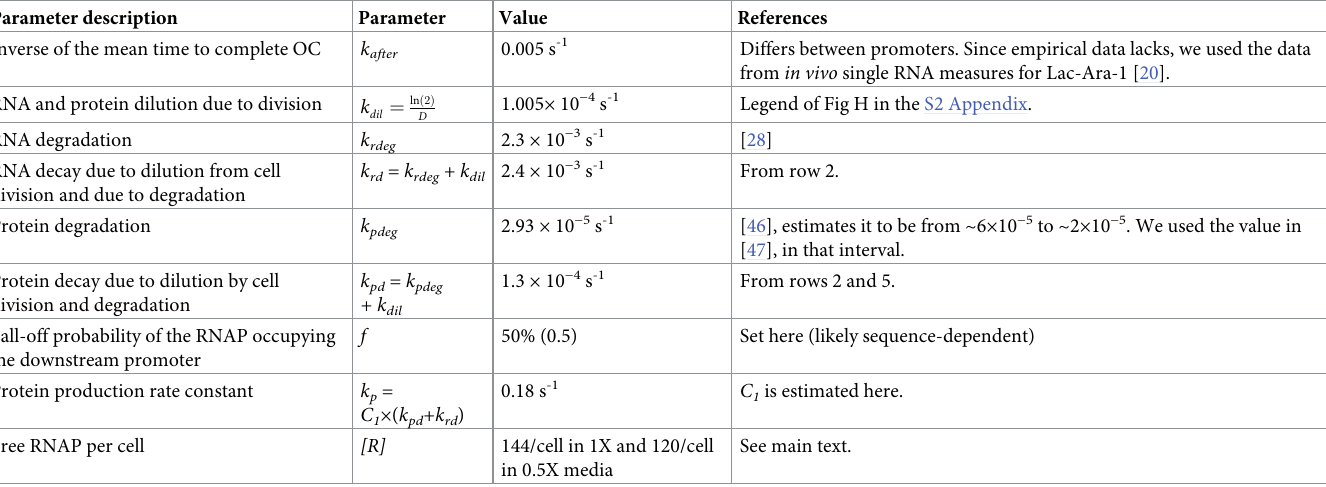
Table 2. Parameter values imposed identically on all